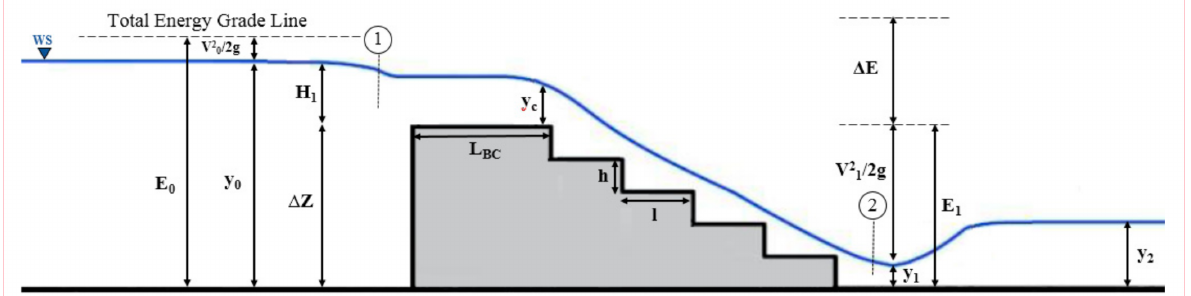
Figure 3. Main involved parameters on energy dissipation flow over stepped